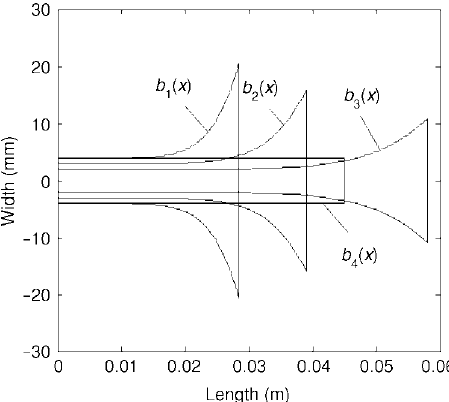
Figure 11 Optimised configuration of caudal fin.